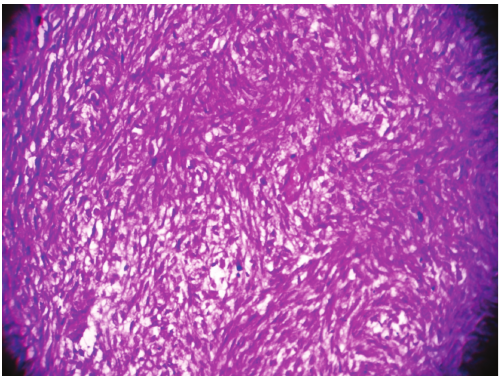
Figure 4: Photomicrograph showing areas of sarcomatous over- growth having stromal cells displaying obvious cytologic atypia and increased mitotic figures (H&E stain, ×